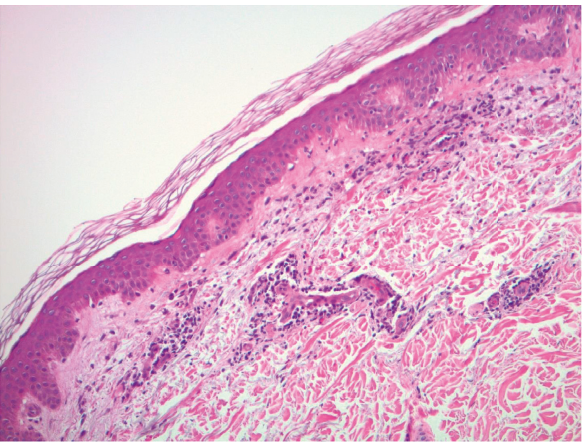
Figure 3: H&E (10x) shows a perivascular infiltrate with fibrinoid changes consistent with leukocytoclastic vasculitis.